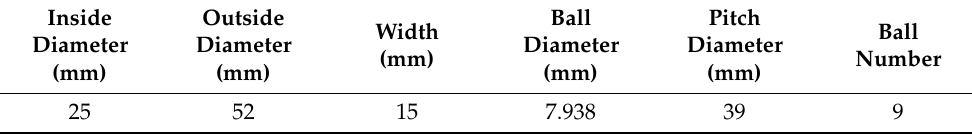
Table 1. Parameters of bearing 6205-2RS JEM SKF.